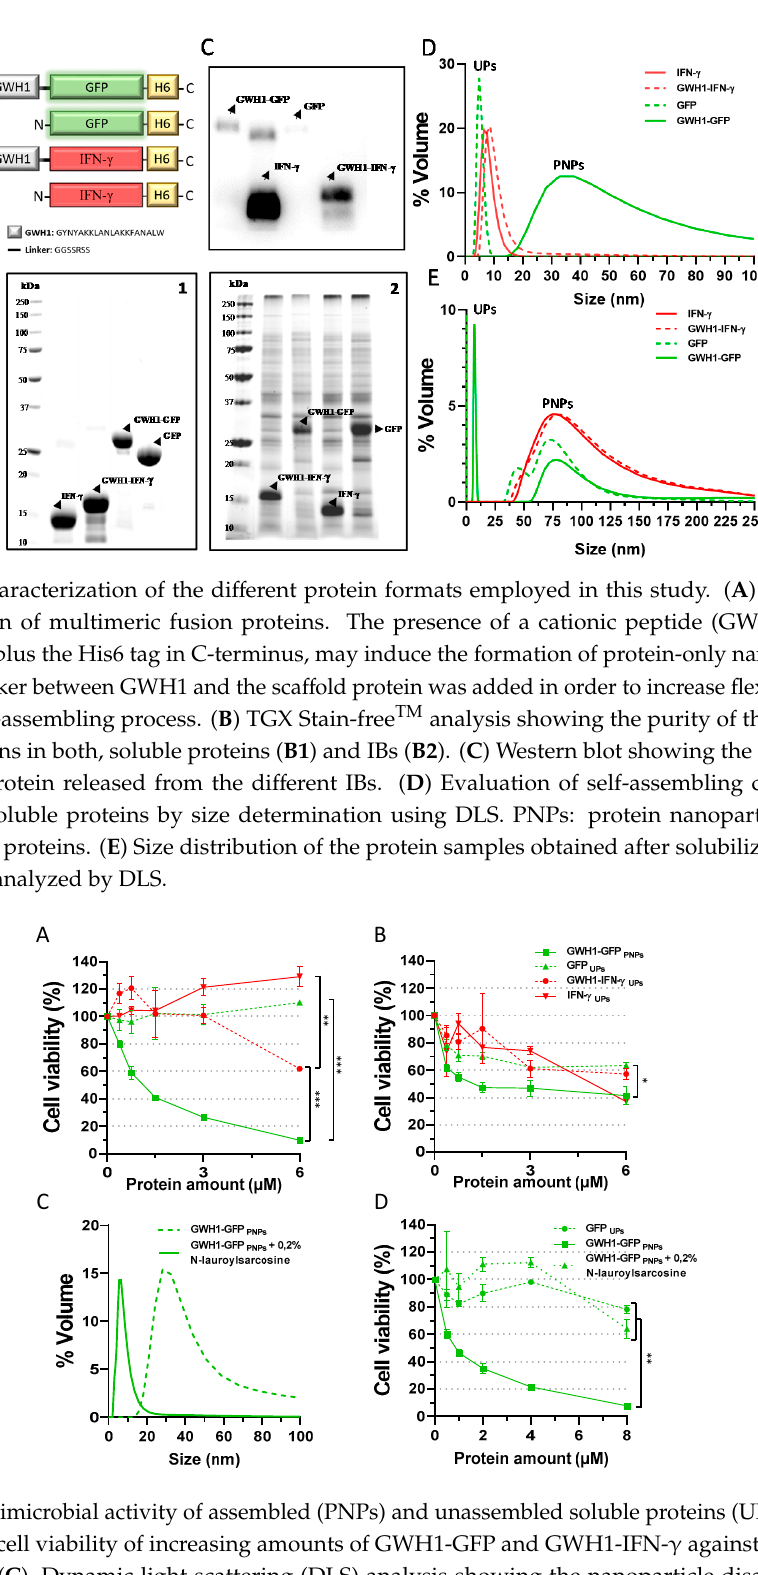
the the mean ± standard